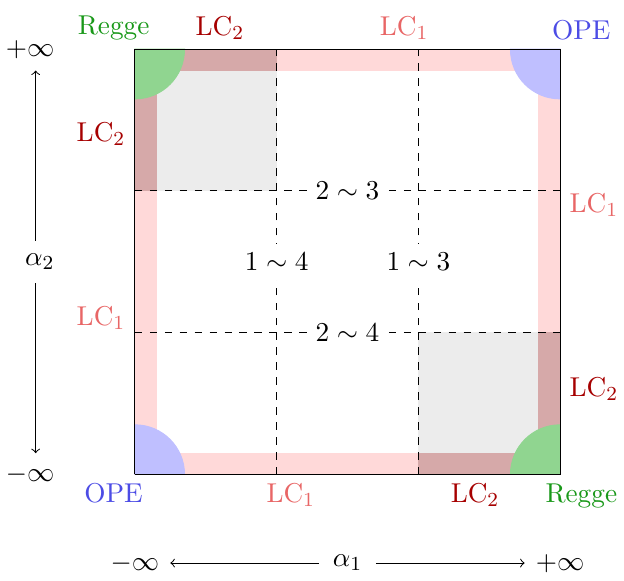
Figure 6. Integration region for the double light-transform of a Wightman function (4.3). The 1 × 2 OPE converges in the white region (the “first sheet”), but it does not necessarily converge in the gray-shaded region (the “second sheet”). The OPE limit is indicated in blue, the Regge limit in green, the lightcone limit on the first sheet (LC 1 ) in light red, and the lightcone limit on the second sheet (LC 2 ) in dark